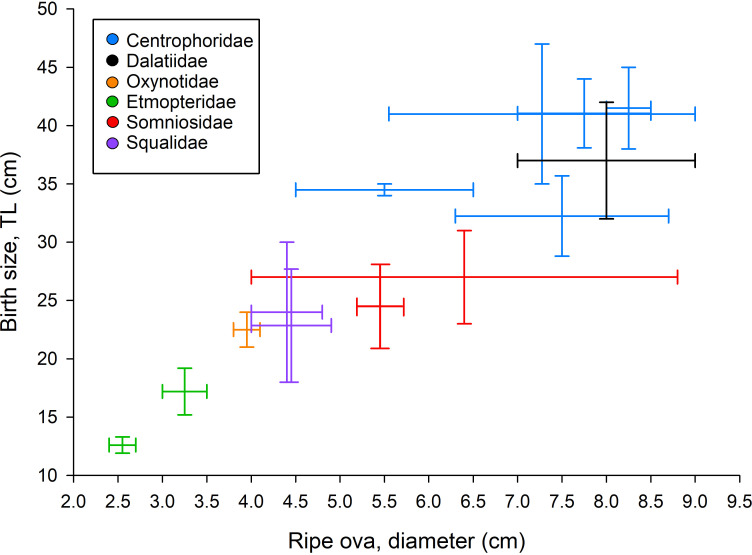
Correlation between size of ripe ova and body length-at-birth.Acquired data on birth size (TL, cm) plotted against size of ripe ova (diameter, cm) for 13 Squaliforms representing six families. Following the order on the X-axis, species are Etmopertus spinax, Centroscyllium fabricii, Oxynotus centrina, Squalus acanthias, Squalus megalops, Somniosus rostratus, Centrophorus moluccensis, Centroscymnus coelolepis, Centrophorus granulosus, Centrophorus uyato, Centrophorus squamosus, Dalatias licha, and Centrophorus sp. 1 (see S4 Table).